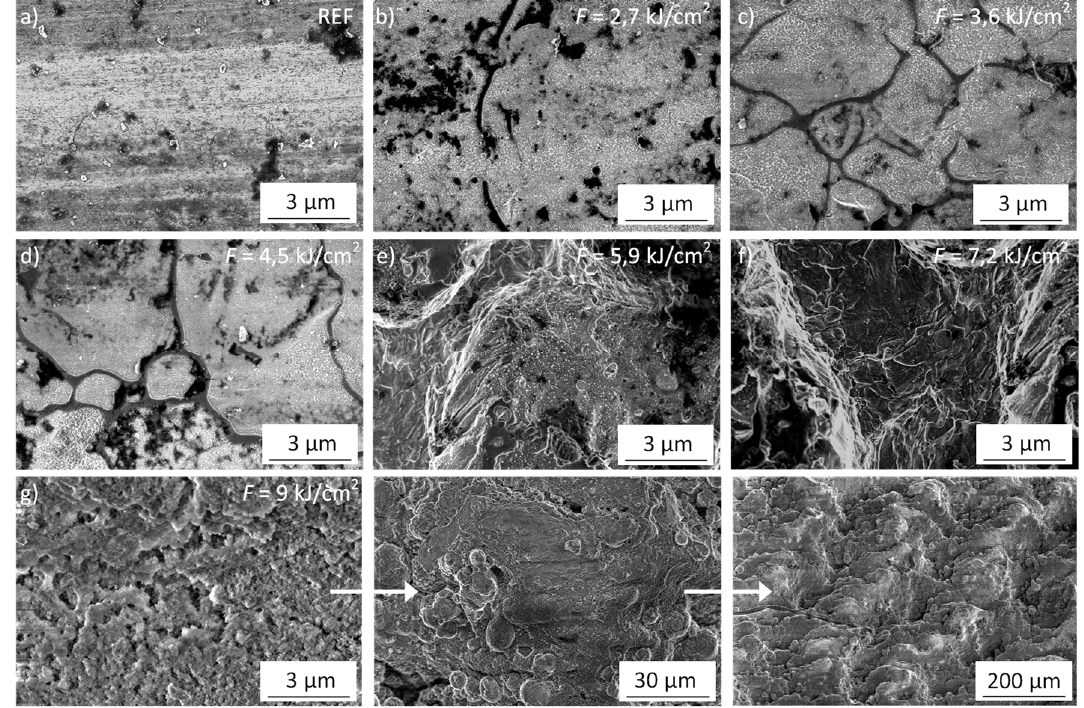
Figure 1. Microscopic images of the surface of aluminium 5754, ( a ) reference sample and after laser irradiation with the laser fluence, ( b ) 2.7, ( c ) 3.6, ( d ) 4.5, ( e ) 5.9, ( f ) 7.2, and ( g ) 9 kJ/cm 2 . To better